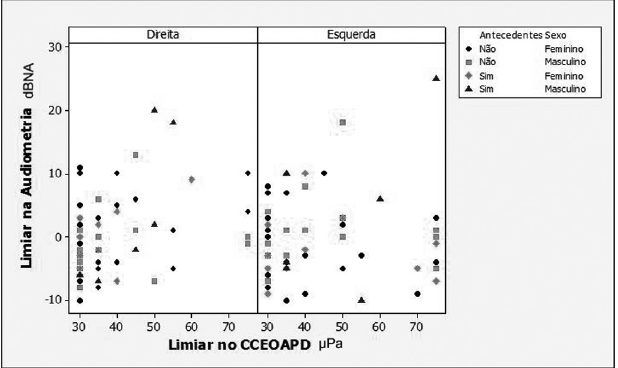
Figura 2. Diagrama de dispersão dos limiares audiométricos e dos limiares das curvas de crescimento das EOA-PD, considerando as variáveis: orelha, antecedentes de otite média e sexo - 3000 Hz.